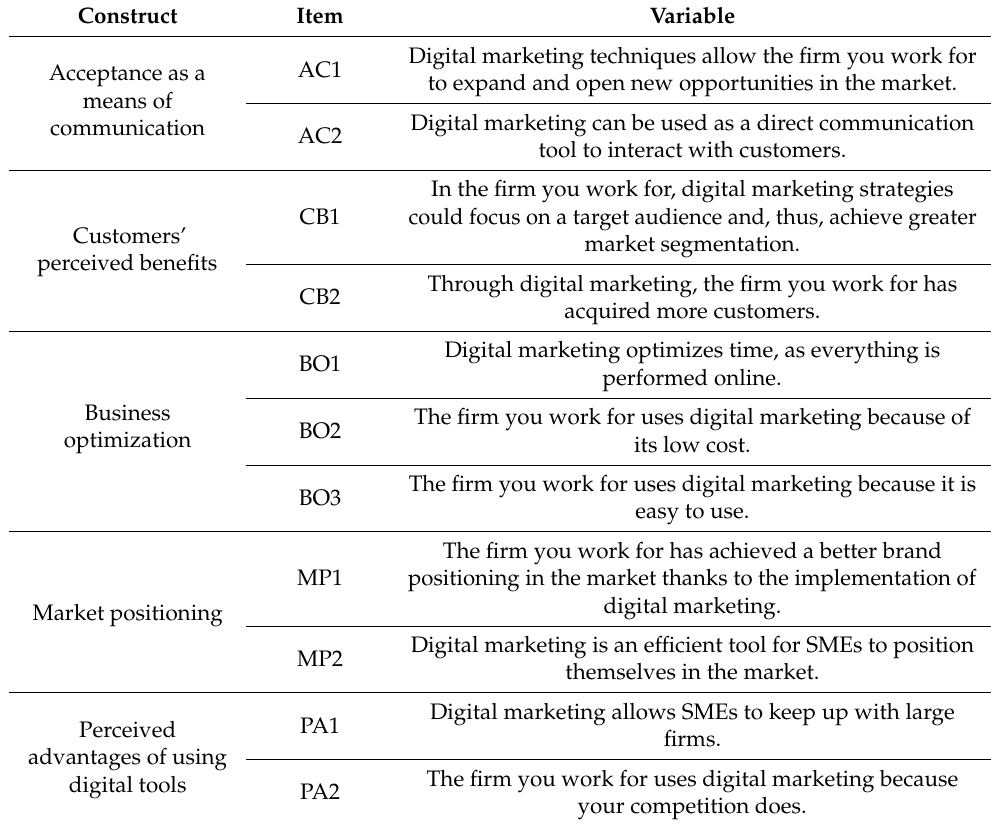
Table 2. Constructs and variables employed in the